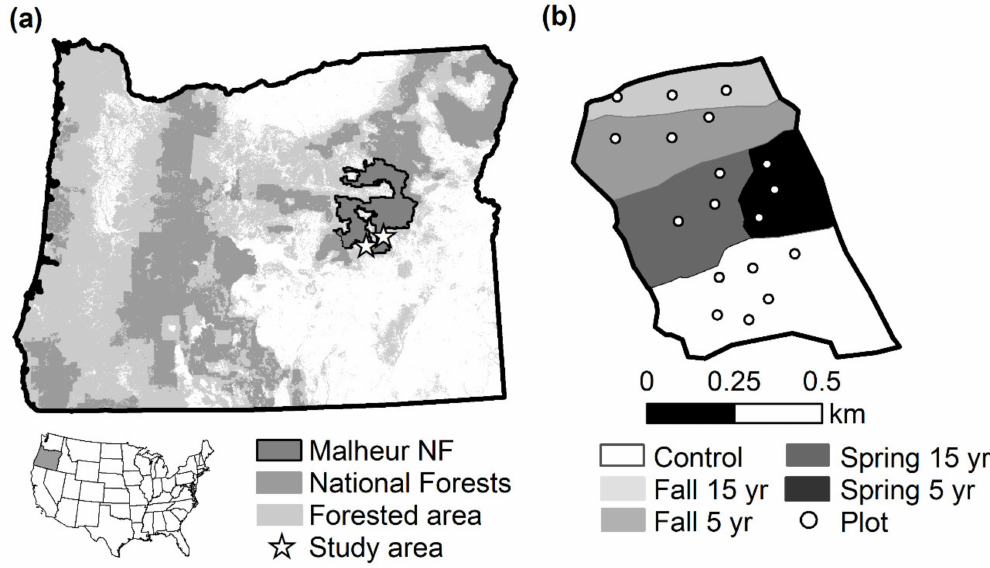
Figure 1. Study area locator map: ( a ) Study area within Oregon, USA; ( b ) Example study design for one stand (Kid Flat) with season (Control = no burning, spring, or fall) and interval (5-yr, 15-yr) of prescribed burning, and plot